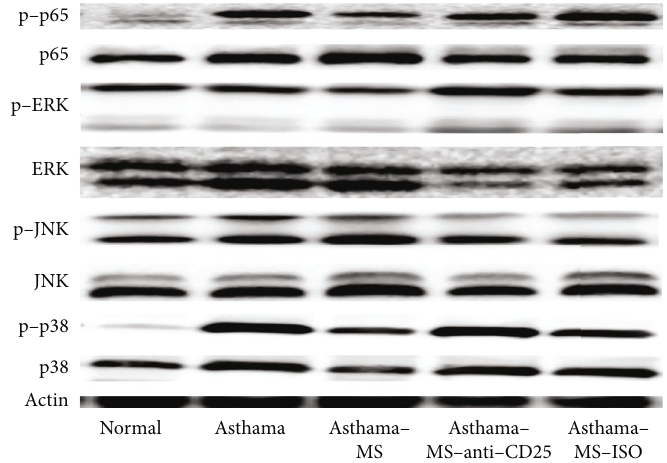
Figure 5: MS alleviates lung injury in asthmatic mice via the NF- κ B and MAPKs signaling pathways. Representative western blots of protein expression of p-p65, p65, p-ERK, ERK, p-JNK, JNK, p-p38, and